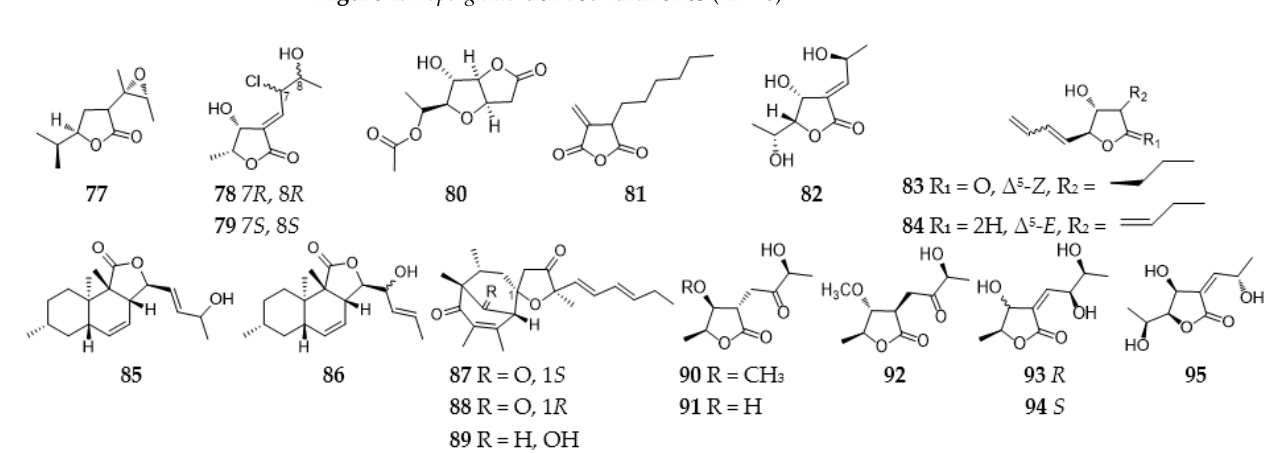
Figure 4. Aspergillus -derived furanones ( 44 – 76 ).